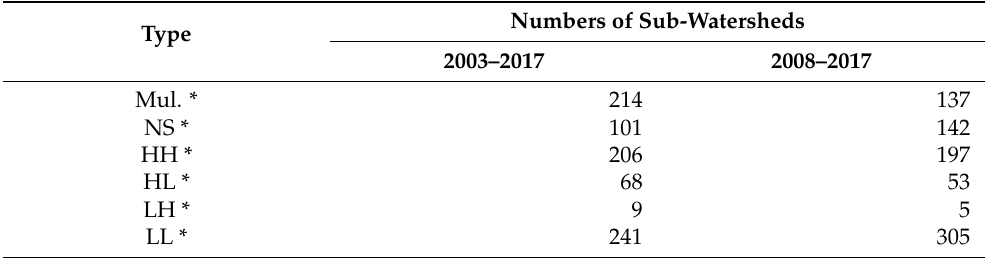
Figure 7. Distribution of landslide spatial cluster and outlier using the Anselin Local Moran’s I index. Table 3. Statistical data of landslide spatial clusters and outlier analyses in Taiwan.